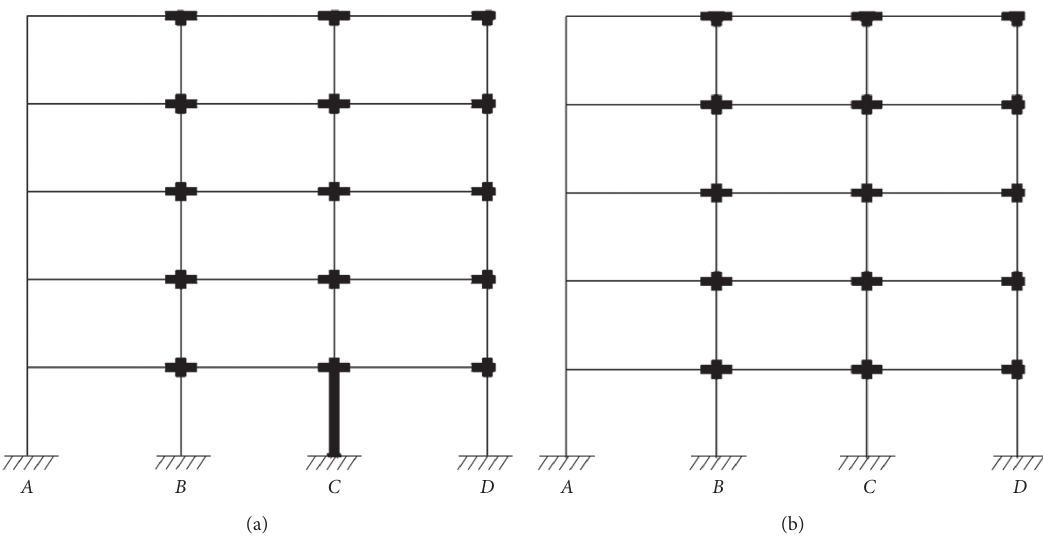
Figure 6: CFST plane frame structure model. (a) Model via the DS method. (b) Model via the AP method.